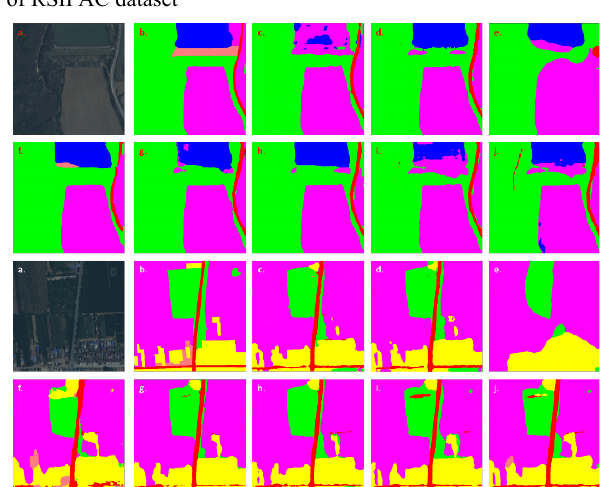
Figure 11. Examples for classification results of general study on the RSIPAC dataset, images marked with a are the input images, and with b , c , d , e , f , g , h , i , j denote the ground truth labels and corresponding results of HRNet, PSA + HRNet, ResNet152, PSA + ResNet152, UNet, PSA + UNet, Deeplab v3+, PSA + Deeplab v3+ . Corresponding colors for land cover classes are listed in Tab.